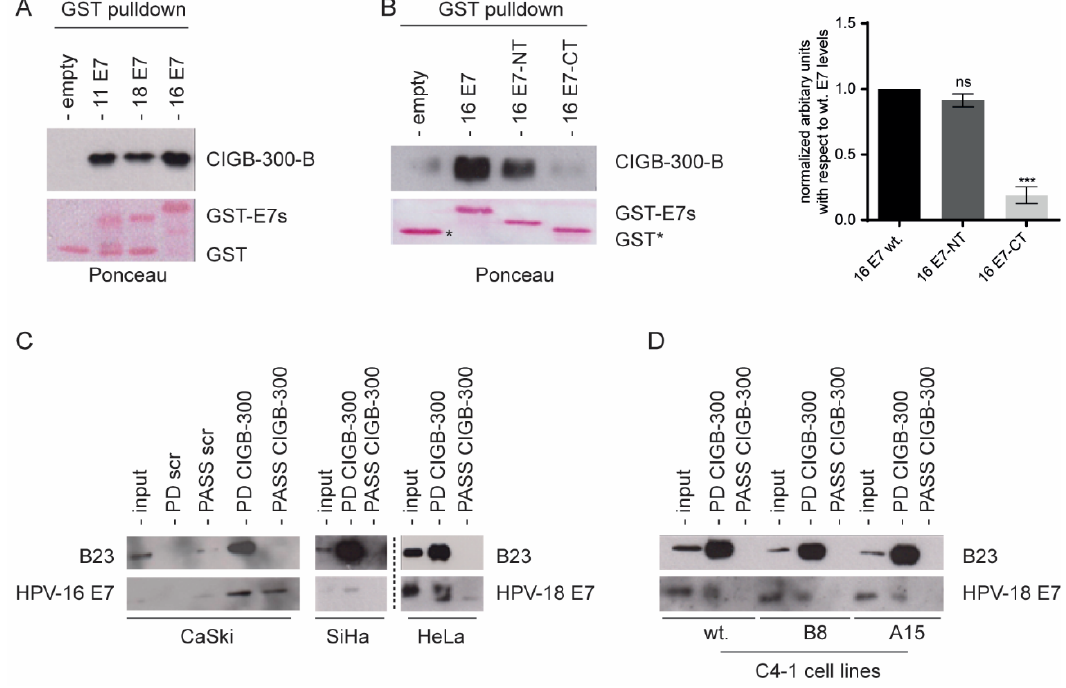
Figure 1. In vitro physical interaction of CIGB-300 with E7 protein. Western blot analysis of in vitro pull-down fractions using CIGB-300 and scrambled peptide, both conjugated to biotin as a bait to capture interacting proteins. GST pull-down was carried out using the purified GST-tagged E7 from HPV-11, HPV-16, HPV-18 ( A ) and HPV-16 E7 N-terminus and HPV-16 E7 C-terminus ( B ). The GST fusion proteins were incubated 1 h with CIGB-300, then the CIGB-300-E7 interaction was resolved by 20%-SDS-PAGE and analyzed by western blot. The top panels show the immunoblot analysis for CIGB-300 using an anti-streptavidin antibody, and the lower panels show the Ponceau staining for different GST-fusion proteins. The position of empty GST (*) is shown. Relative densitometry analysis values of bands normalized to HPV-16 E7 are indicated. In vitro pull-down was performed with cellular lysates from CaSki, SiHa, HeLa ( C ), as well as C4-1 wildtype and mutant cells ( D ) incubated 1 h with CIGB-300 (100 μ M). Subsequently, 20 μ L of streptavidin magnetic beads was added to each reaction, and CIGB-300-interacting proteins were eluted, resolved on 15%-SDS-PAGE and subjected to western blot. The scrambled control peptide sequence is a stretch of 10 random amino acids. Input: cellular extract. PD: pull-down fractions. PASS: flow-through fraction. Results from ( B ) represent means from three independent experiments, while those from ( A , C , D ) are representative of two independent experiments. Statistically significant differences are represented as *** p <